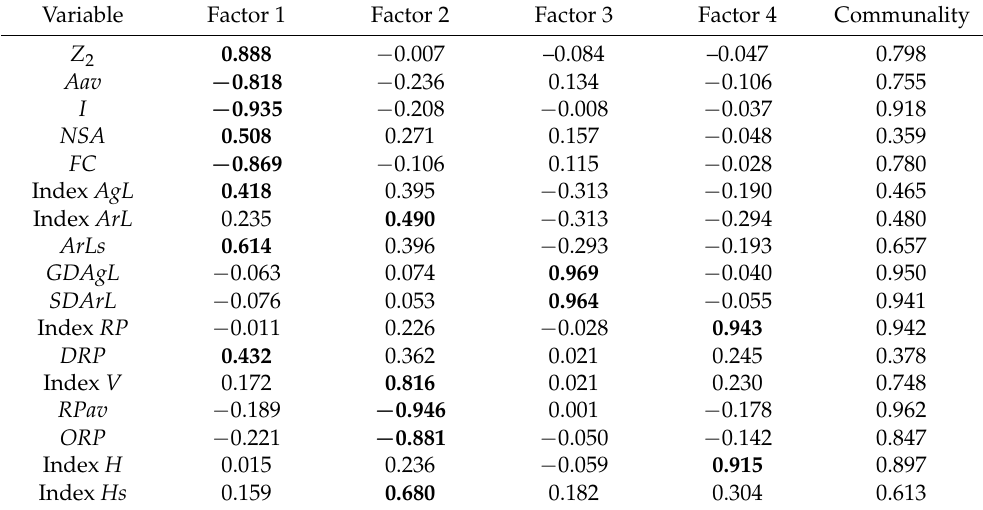
Table 10. Results after varimax rotation (low–low). Rotation method: varimax with Kaiser normaliza- tion. Bold values indicate correlated variables included in the PCs >